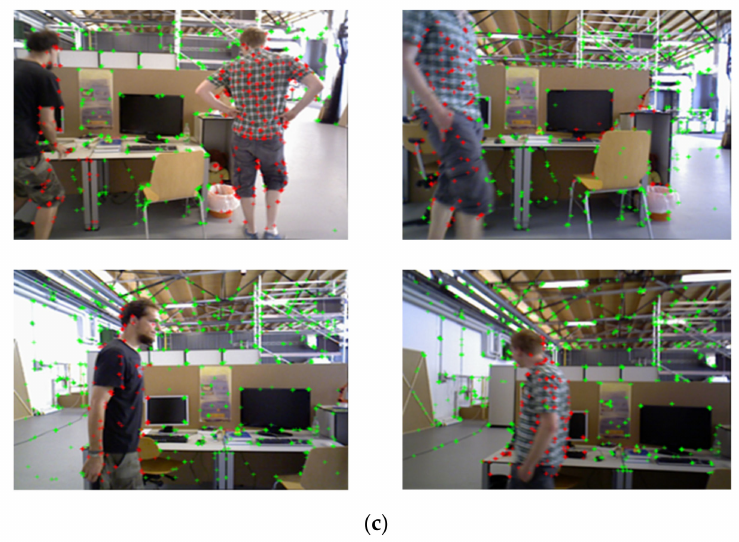
Figure 8. The identification results of static and dynamic feature points in the dynamic sequence of “ fr3_walking_xyz ”. ( a ) The raw images; ( b ) The dynamic segmentation results; ( c ) The extraction results of static and dynamic point